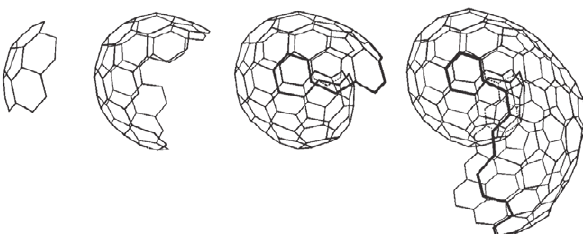
Figure 5. Kroto and Mackay’s hypothetical spiral graphitic carbon structures, adapted from KROTO